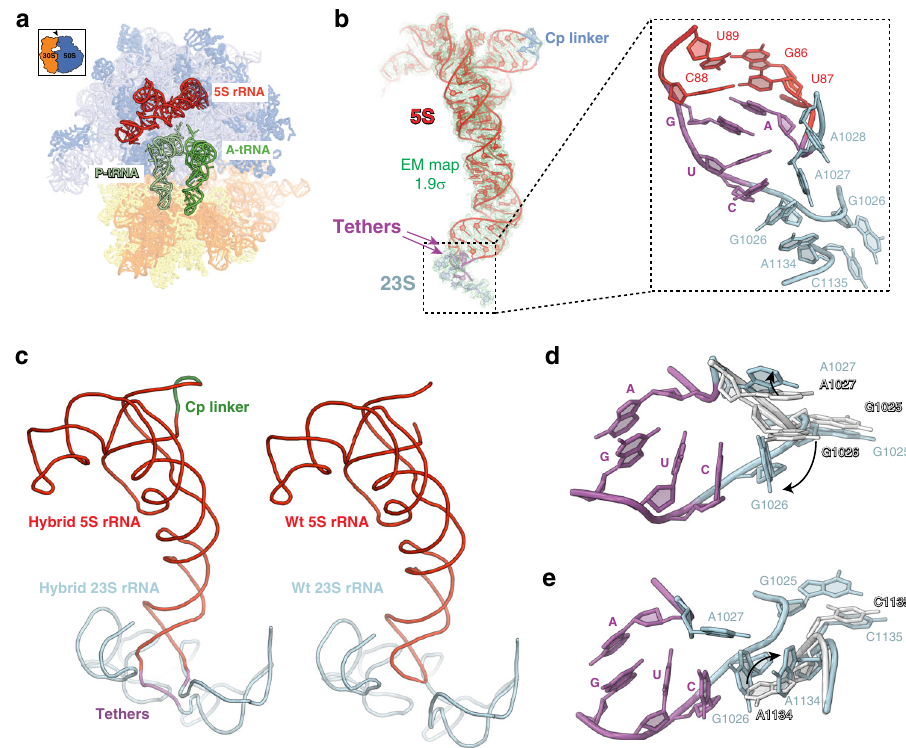
Fig. 6 Structure of the active ribosomes with the hybrid 23S-cp5S rRNA. a Cryo-EM reconstruction of the 23S-cp5S rRNA 70S ribosome with A and P sites occupied by tRNAs (green). 23S rRNA-linked cp5S rRNA is shown in red. b Fitting of tethered cp5S rRNA in the cryo-EM density. cp5S rRNA is red, tethers are purple and 23S rRNA nucleotides are light-blue. Inlet shows the modeled positions of nucleotides involved in forming the cp5S - 23S rRNA junction (see also Supplementary Fig. 4a). c The path of the rRNA backbone in wt ribosomes (left panel) 67 and in ribosomes with hybrid 23S-cp5S rRNA (right panel) deduced by cryo-EM analysis. Colors are as in b . d , e Tethering 23S and cp5S rRNA introduces minimal perturbation at the junction site with only G1026 and A1027 at the site of attachment ( c ) and a more distant A1134 ( d ) undergoing conformational transitions. The orientation of the 23S rRNA residues in the wt ribosomes is shown in gray, 23S rRNA nucleotides of the mutant ribosome are light blue and the RNA residues belonging to the 23S rRNA-cp5S rRNA tethers are